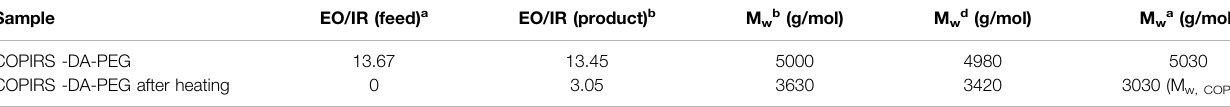
TABLE 1 | Molecular weight (M w ) of COPIRS-DA-PEG after different treatments. Sample COPIRS